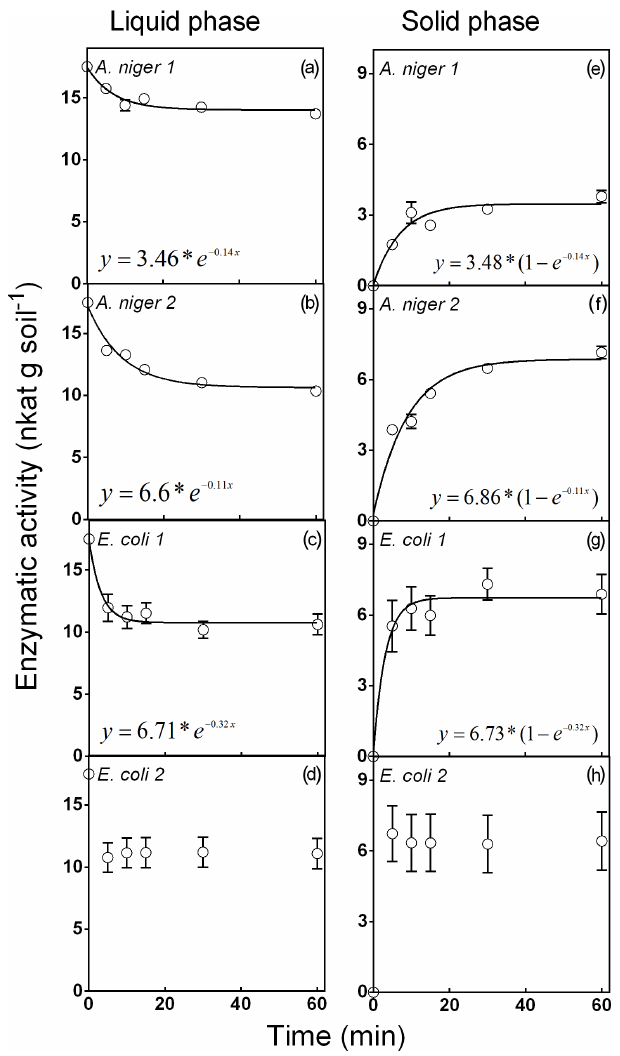
Figure 1. Phytase activity distributed in the liquid and solid phases for the phytase soil adsorption experiment. Four purified phytases (two isolated from A. niger and two from E. coli ) were evaluated. Experiments were performed with the seven soils described in Ta- ble 1. Each point represents the average of three observations minus the controls described in Sect. 2. Bars represent the standard error of the